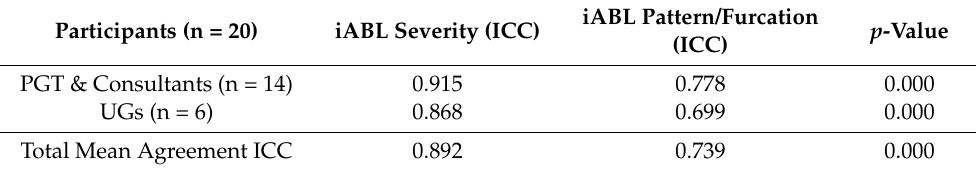
Table 5. Mean inter-examiner agreement scores for all participants (n =